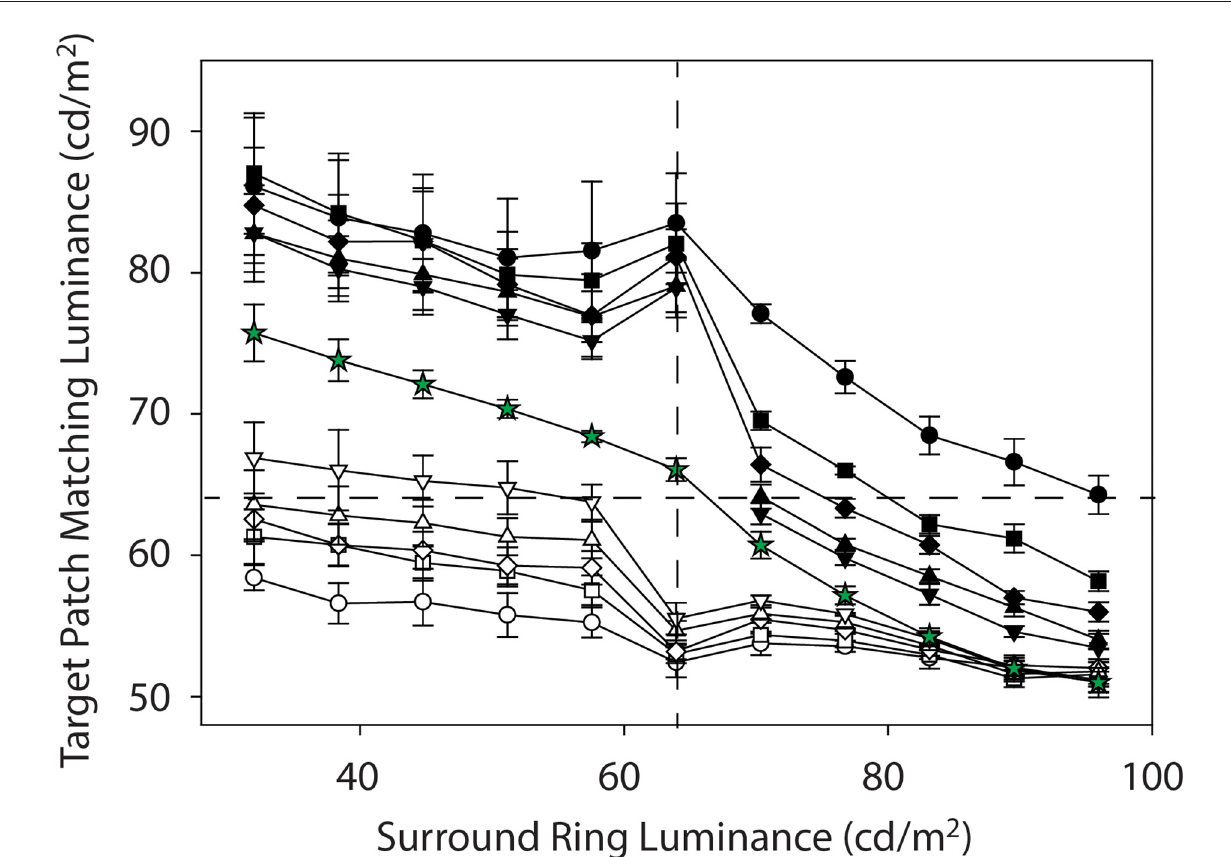
FIGURE5 Mean target patch matching luminance on the 0.0 cd/m 2 remote background (black symbols) and on the 96 cd/m 2 (white symbols). Symbol shapes represent the various adjacent surround ring widths (0.1 ◦ = circles, 0.3 ◦ = squares, 0.5 ◦ = diamonds, 1.0 ◦ = triangles, 2.5 ◦ = inverted triangles). The matches obtained on the variable full-field surround (green stars) are included for reference while those on the 64 cd/m 2 background (red symbols) have been removed for